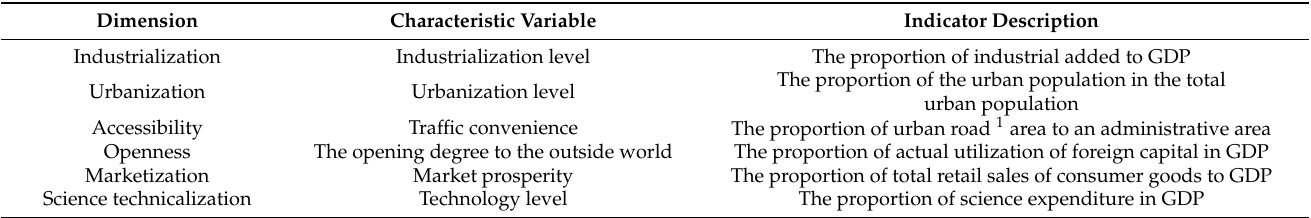
Table 3. Selection of characteristic variables of the influence of economic